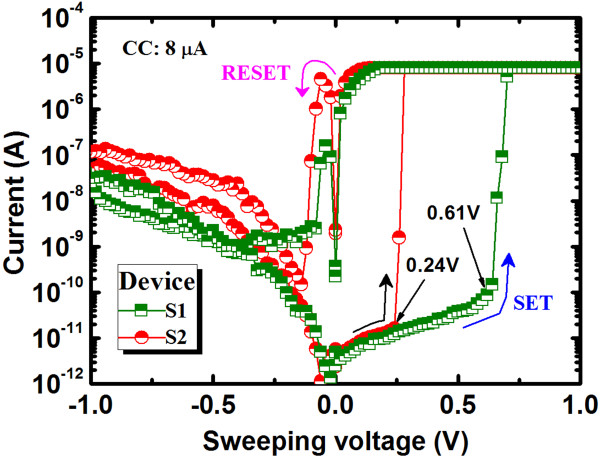
TypicalI-Vhysteresis of the Al/Cu/Ge0.2Se0.8/W and Al/Cu/Ge0.5Se0.5/W memory devices.